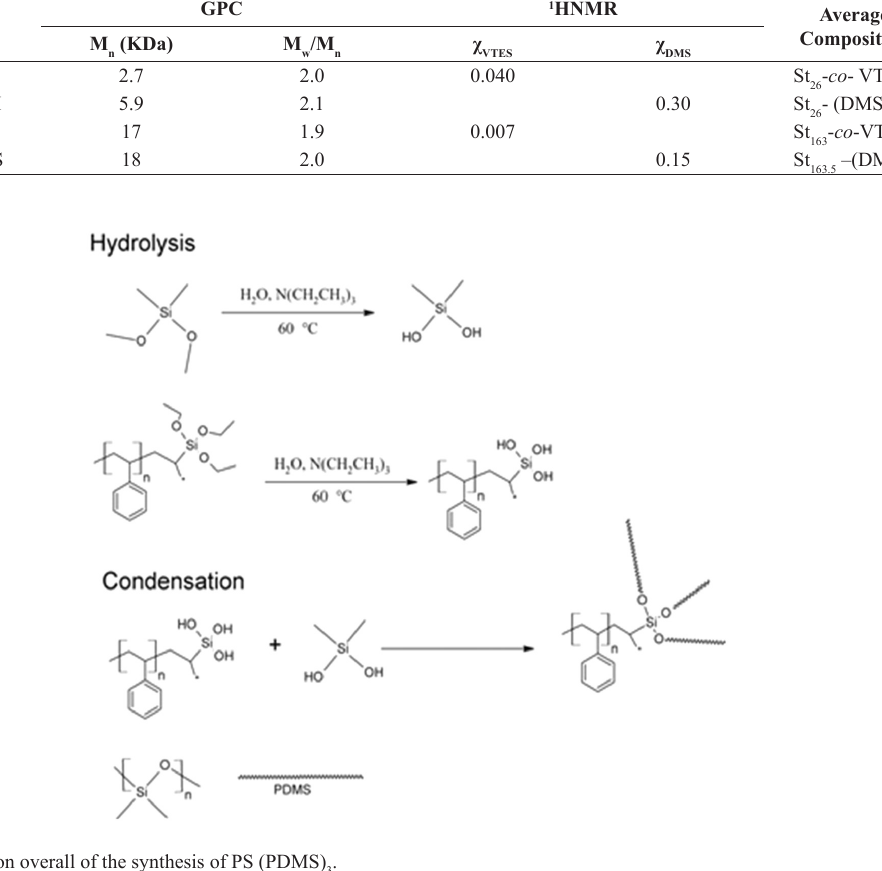
Fig 2. The reaction overall of the synthesis of PS (PDMS)